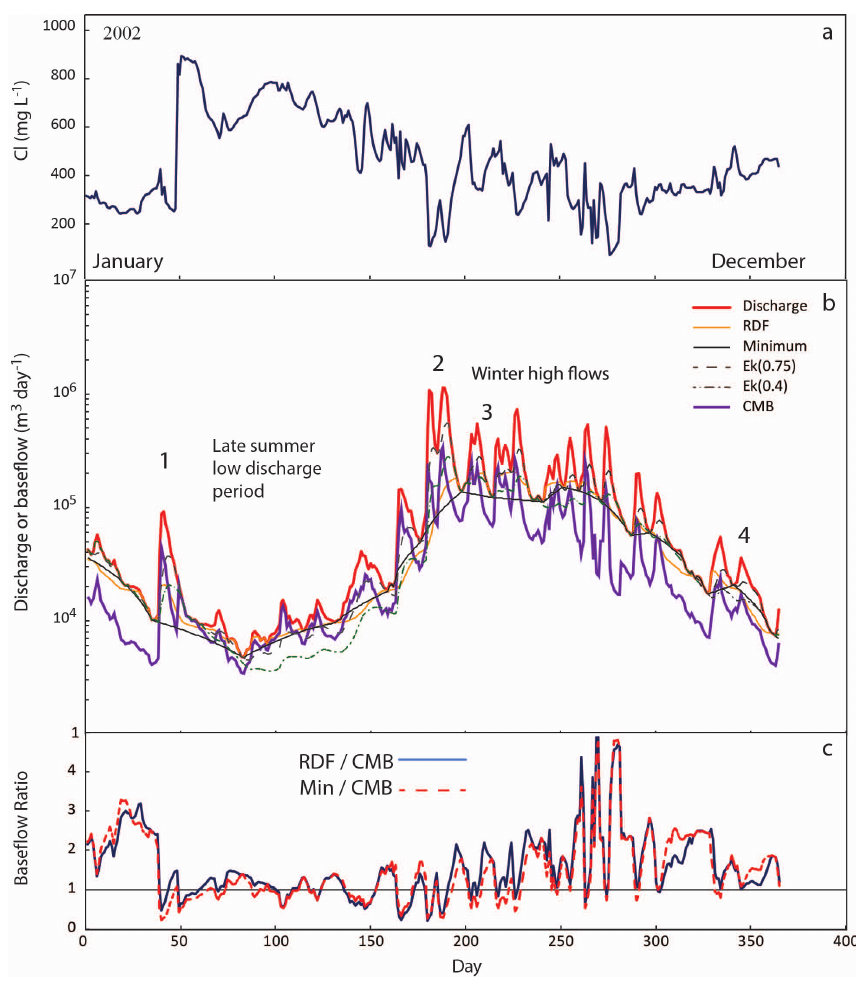
Fig. 4. (a) Variation in Cl concentrations in the upper Barwon River at Winchelsea in 2002. (b) Variation in discharge of the Barwon River at Winchelsea in 2002 and estimated baseflow calculated by the Nathan and McMahon (1990) implementation of the Lyne and Hollick (1979) digital filter (RDF), local minimum (Sloto and Crouse, 1996) (Min), the Ekchardt (2005) digital filter with BFI max =0.75 (Ek(0.75)) and 0.4 (Ek(0.4)), and chemical mass balance (CMB). (c) Ratio of baseflows derived by local minimum and the Lyne and Hollock (1979) digital filter to that estimated by chemical mass balance. Days are from 1 January. Data from Water Resources Data Warehouse